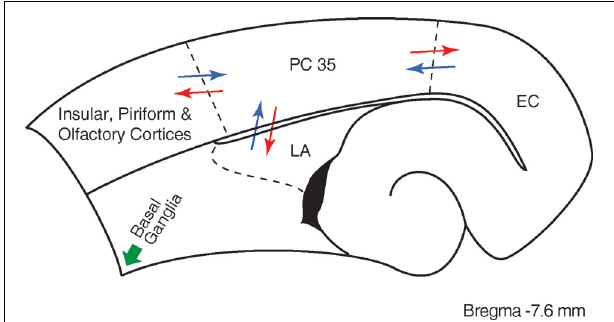
FIGURE 1 | Scheme of the main afferent/efferent connections of the perirhinal cortex (PC, area 35) under physiological conditions. The drawing corresponds to a section taken at 7.6mm from the bregma according to the Paxinos and Watson (2007) atlas. Major afferents projections to the perirhinal cortex (blue arrows) originate from olfactory insular and piriform cortices, lateral amygdala (LA) and entorhinal cortex (EC); conspicuous efferent projections of the perirhinal cortex (red arrows) are directed to these areas as well. Note that subcortical efferents from the perirhinal cortex (green arrows) terminate in several brain regions, including the basal ganglia (cf., Furtak et al., 2007).